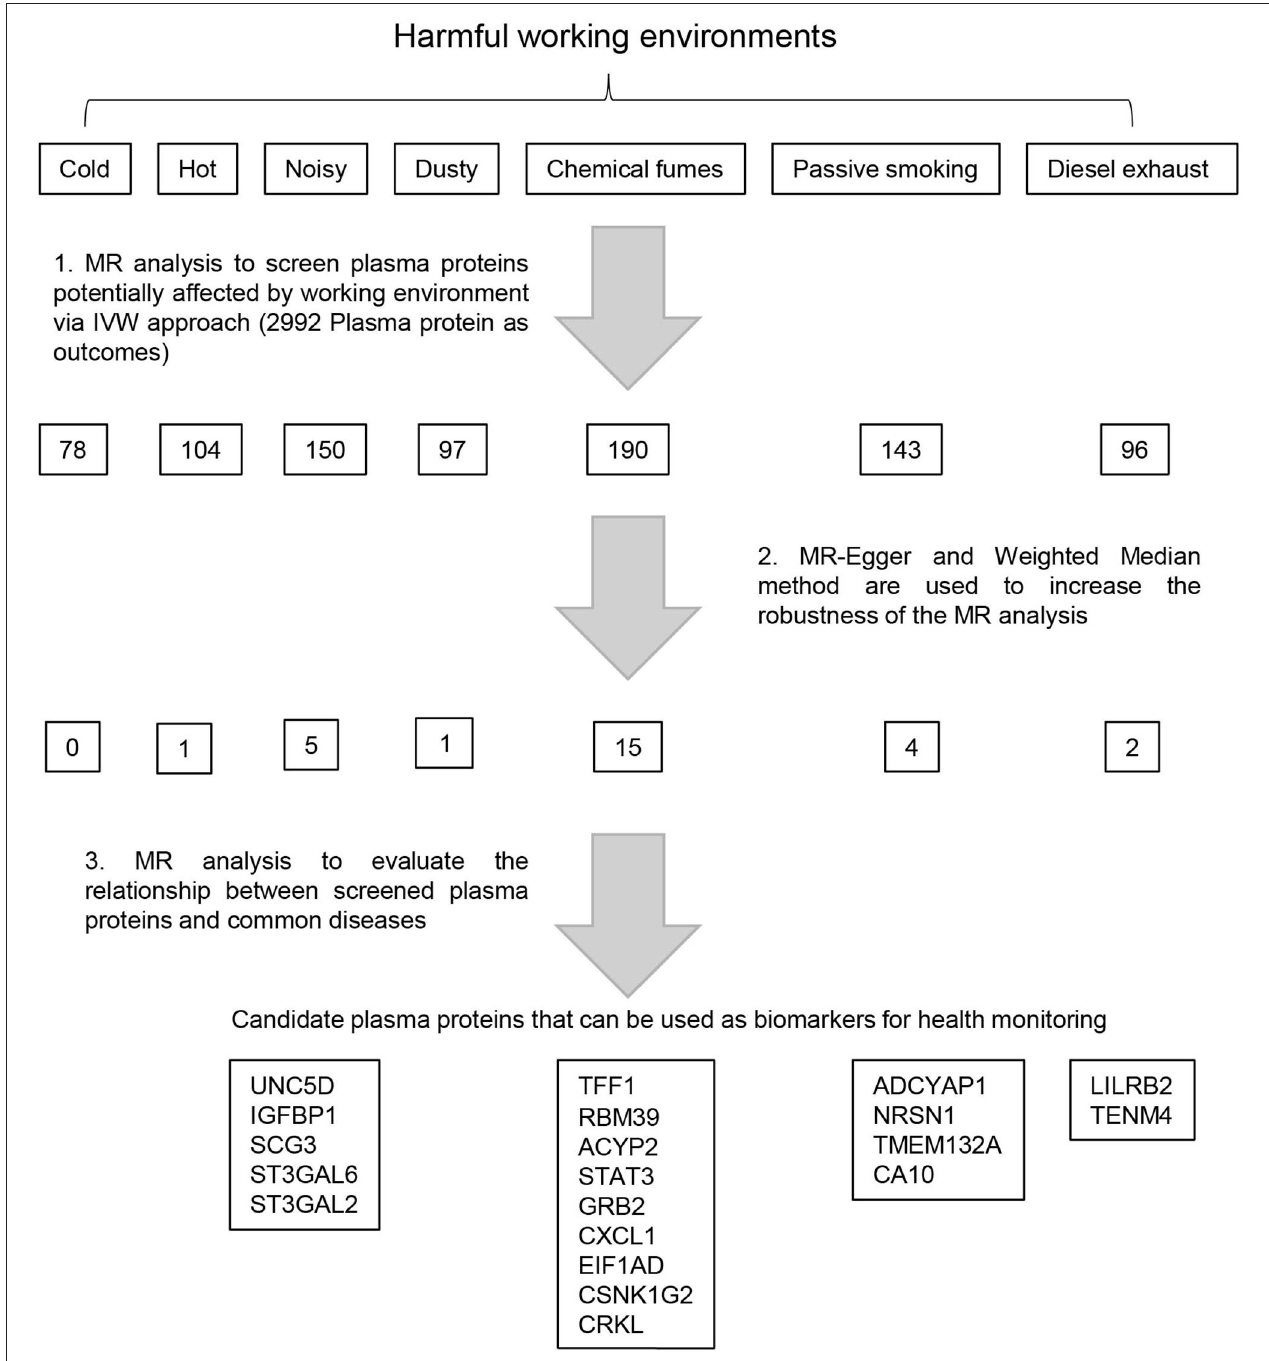
FIGURE 1 | Framework of the study design. Preliminary Mendelian randomization (MR) analysis was performed using Genome Wide Association Study (GWAS) summary data of seven types of harmful working environments as exposures and GWAS summary data of 2,992 plasma proteins as outcomes. The robustness of the MR analysis was subsequently increased using MR-Egger and Weighted Median methods. The GWAS summary data for the selected plasma proteins are then used as exposures to evaluate the relationships between the plasma concentrations of these proteins and the risks of 28 diseases. Plasma proteins associated with the risk of at least one disease were selected as biomarkers to monitor corresponding occupational